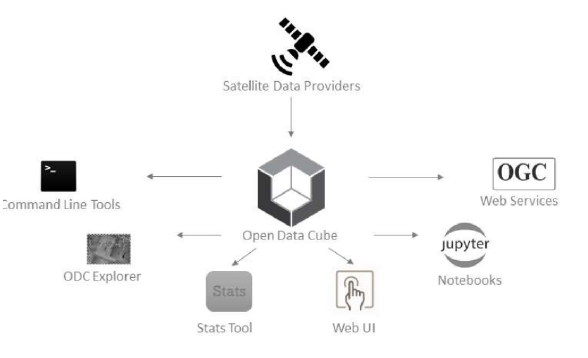
Figure 1 . High level overview of the ODC tools (Open Data Cube, 2021a).